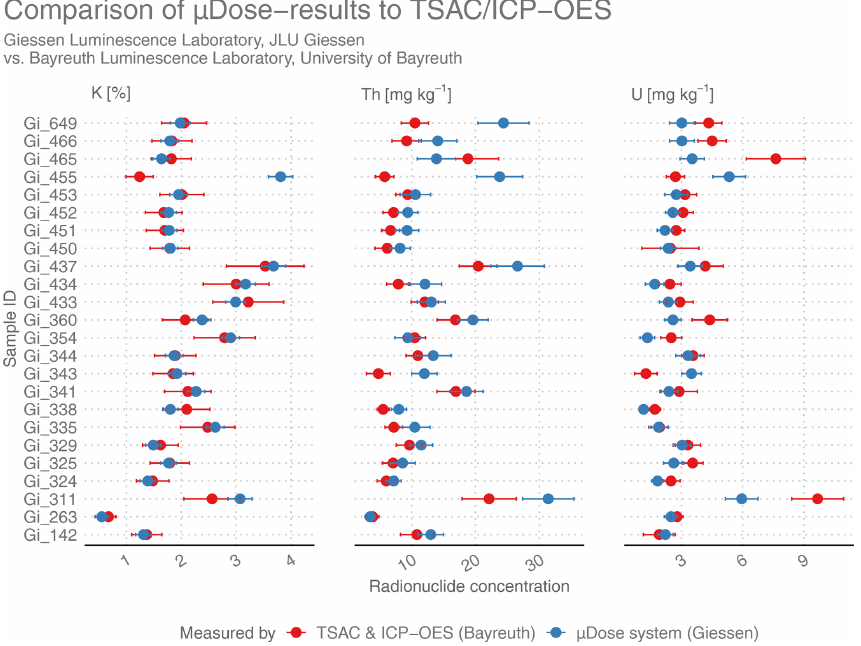
Figure 8. Comparison of results obtained by TSAC (U and Th) in combination with ICP-OES (K) (red symbols) to the findings derived from µ Dose measurements (blue symbols). Please note that the values are given as radionuclide concentrations (% for K; mgkg − 1 for U and